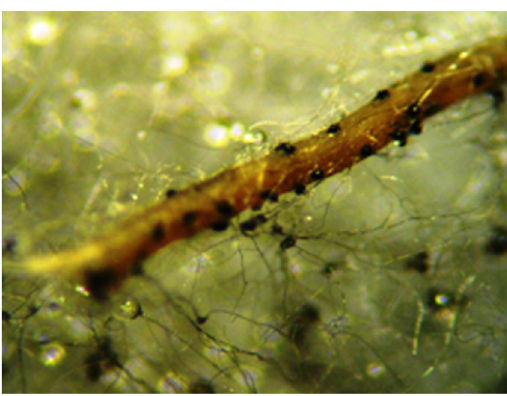
Figure 3. Pycnidial Macrophomina phaseolina structures (100–200 µ m) of fungi on soybean roots. Figure was obtained by